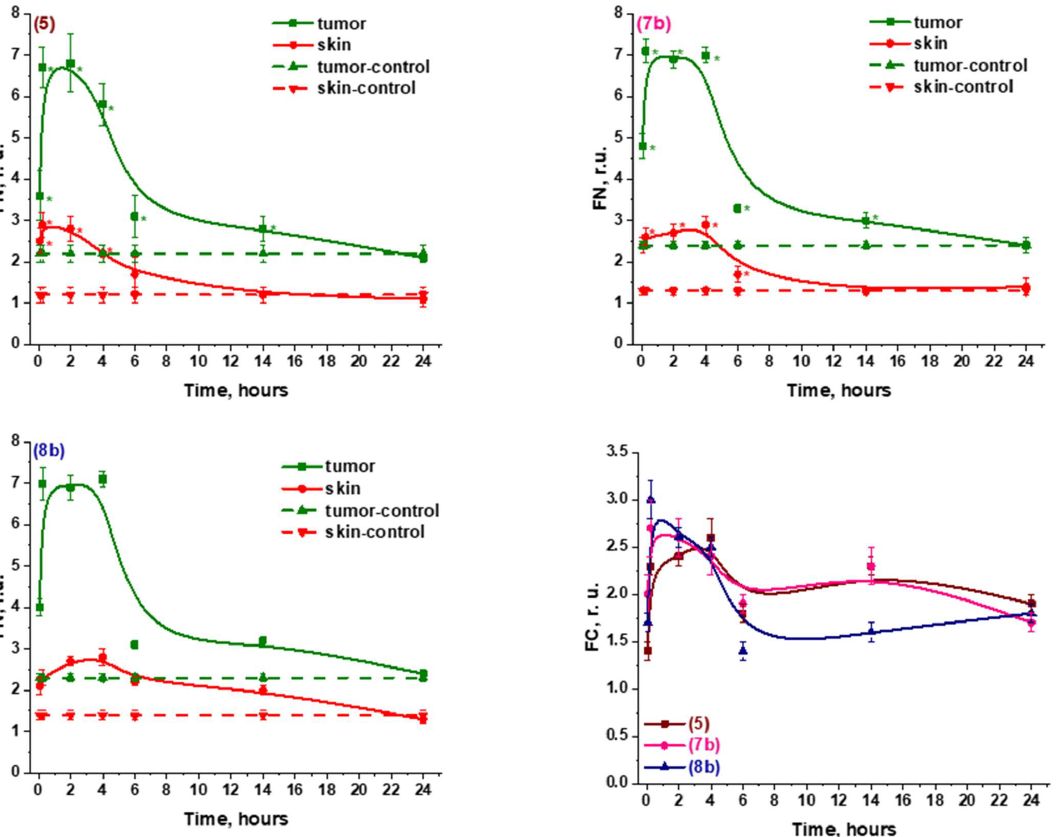
Figure 4. Normalized fluorescence and fluorescence contrast of the compounds in PC-3 tumor tissue and in the surrounding skin in mice, in the time range from 5 min to 24 h. Data are presented with the background values taken into account. Fluorescence was excited by He-Ne laser radiation (λmax = 633 nm). The measurements were performed in the range of 640–900 nm. *— p ≤ 0.05. All the compounds were accumulated in PC-3 adenocarcinoma tissue. Normalized fluorescence of the photosensitizers was instantly detected in tumor tissue and reached the maximum values 15 min after injection. It was maintained at a high level for 2 h after injection of compound ( 5 ) and for 4 h in the case of compounds ( 7b ) and ( 8b ). The longer retention of compounds ( 7b ) and ( 8b ) is apparently caused by the presence of histamine in the photosensitizer (PS) molecule, which promotes binding to receptors on the surface of tumor cells (Figure 4). The elimination of the PS from the tumor and the surrounding tissues occurred 24 h after the intravenous injection. In the surrounding skin, the PS was detected at a level slightly higher than the back- ground values for 14 h after injection. The maximum level of fluorescence contrast (FC) was observed in 15 min to 4 h after injection and ranged from 2.3 ± 0.1 to 3.0 ± 0.2 rel. units.